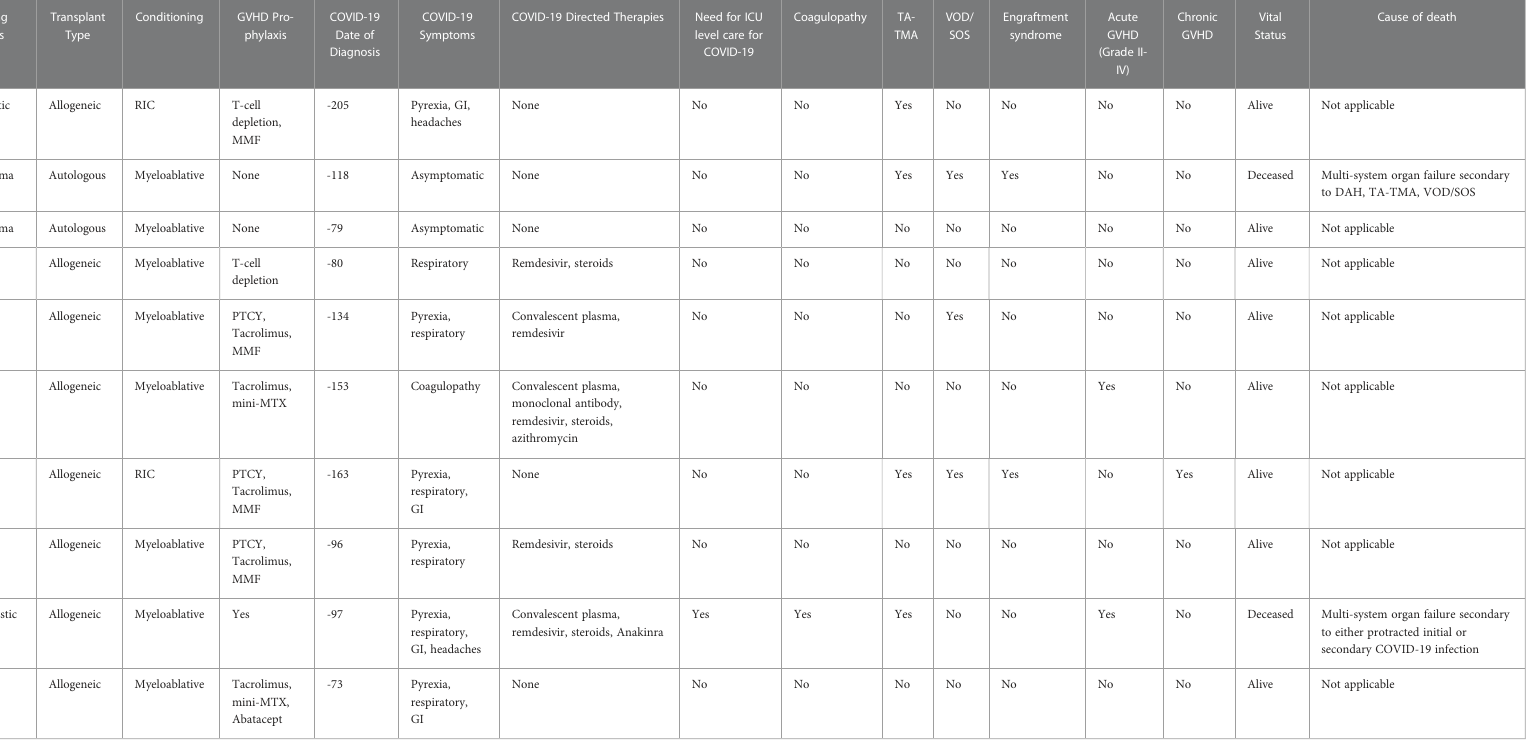
TABLE 4 Case details of all HCT patients who were infected with COVID-19